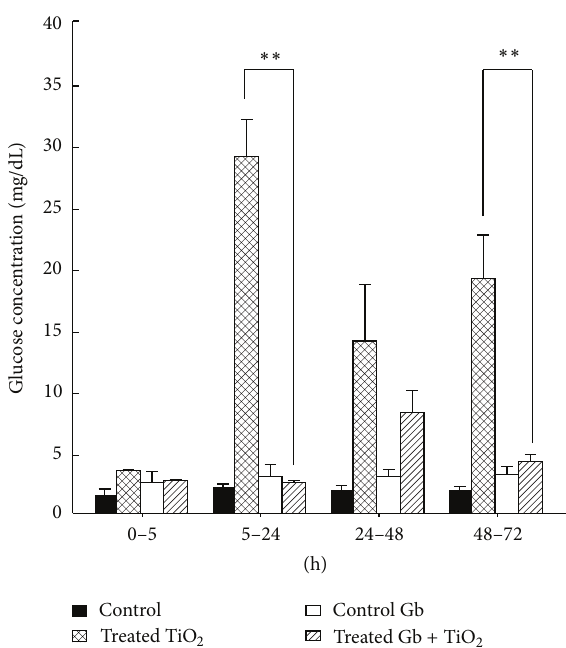
reversed the increase on enzymatic activity of dipeptidy-